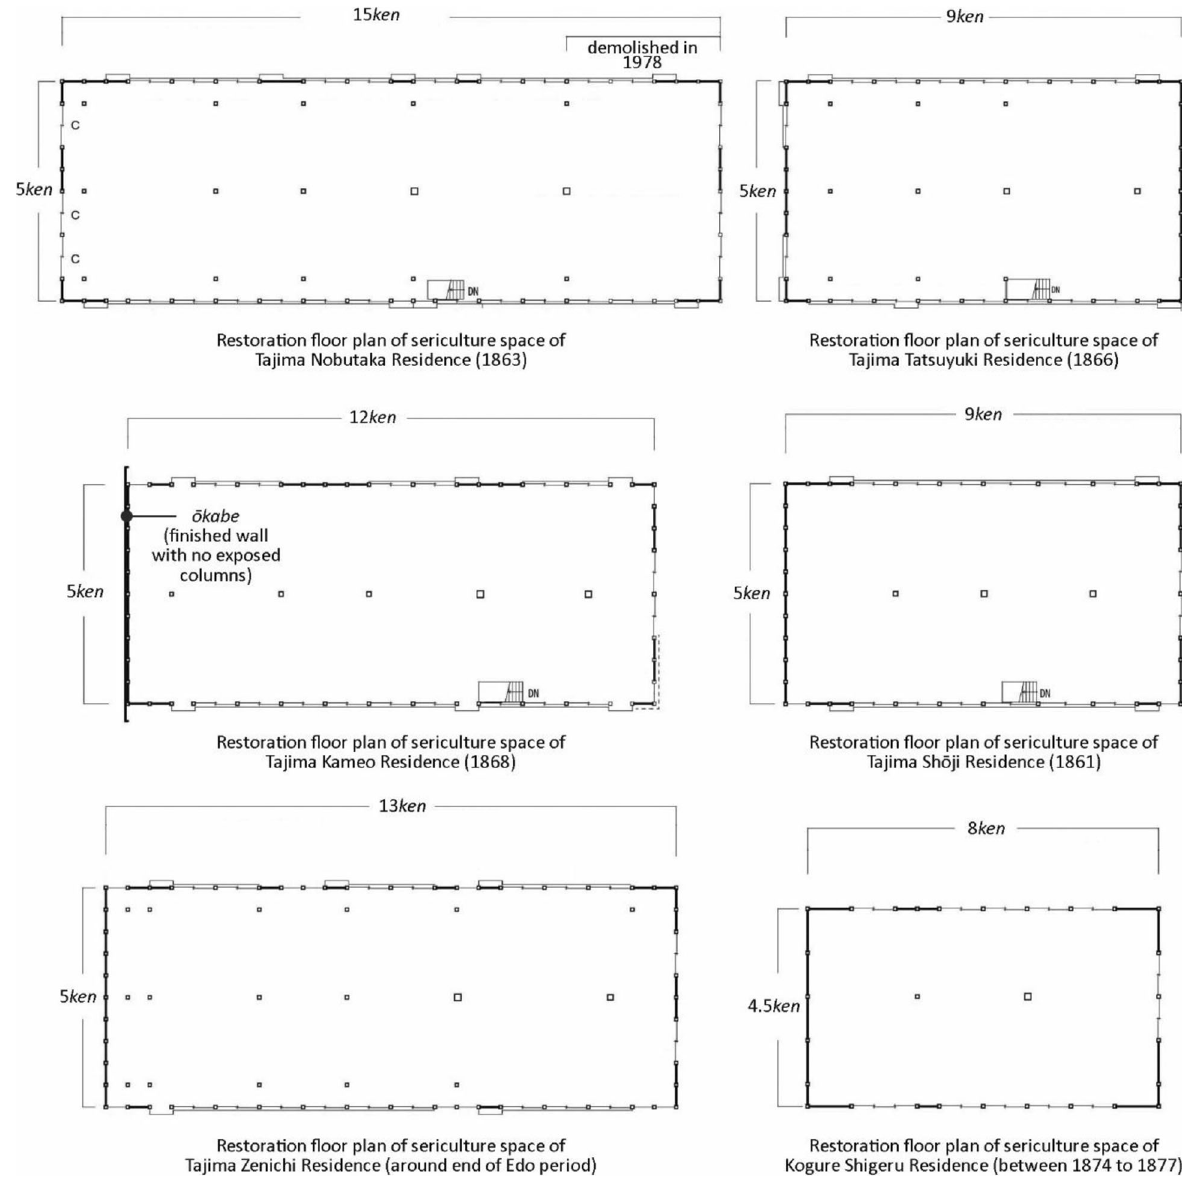
Fig. 7 Restoration floor plans of the sericulture space (upper floor) of former sericulture farmhouses located near Tajima Yahei Sericulture Farm. (Source: Gunma Prefecture 2007; Satoshi Ono)